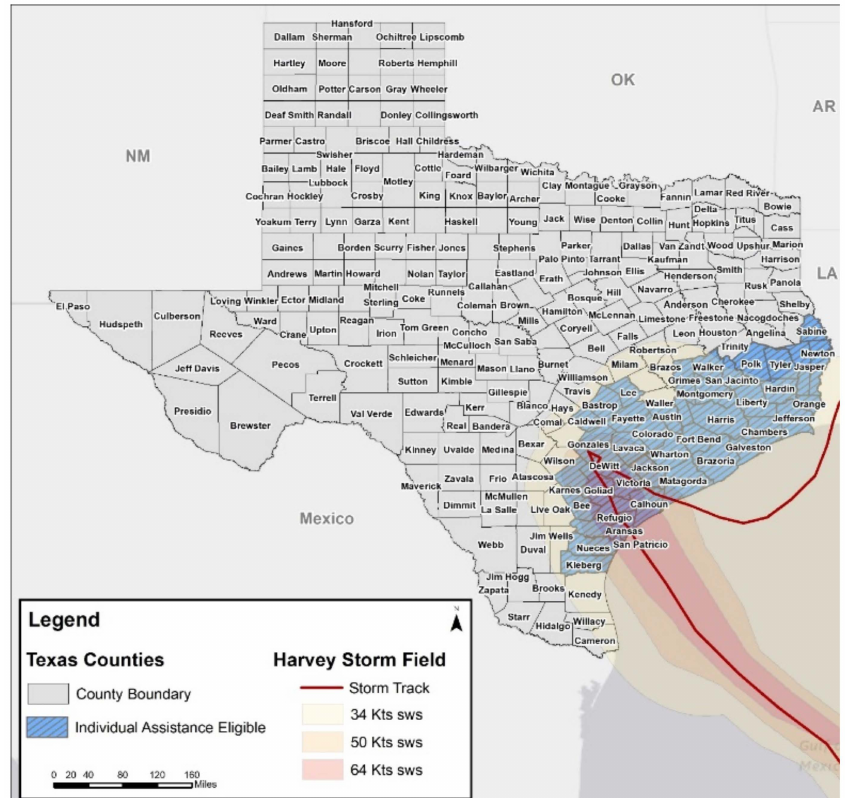
Figure 1. Hurricane Harvey storm track across